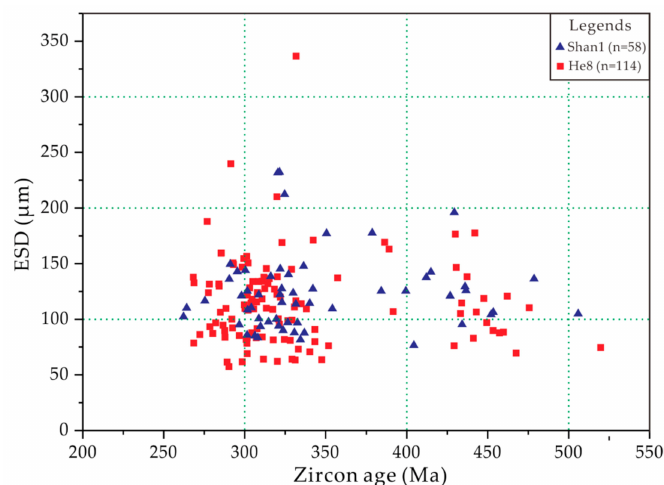
Figure 4. Equivalent spherical diameter (ESD) of zircon grains vs detrital zircon ages in samples. The distribution of ages is independent from